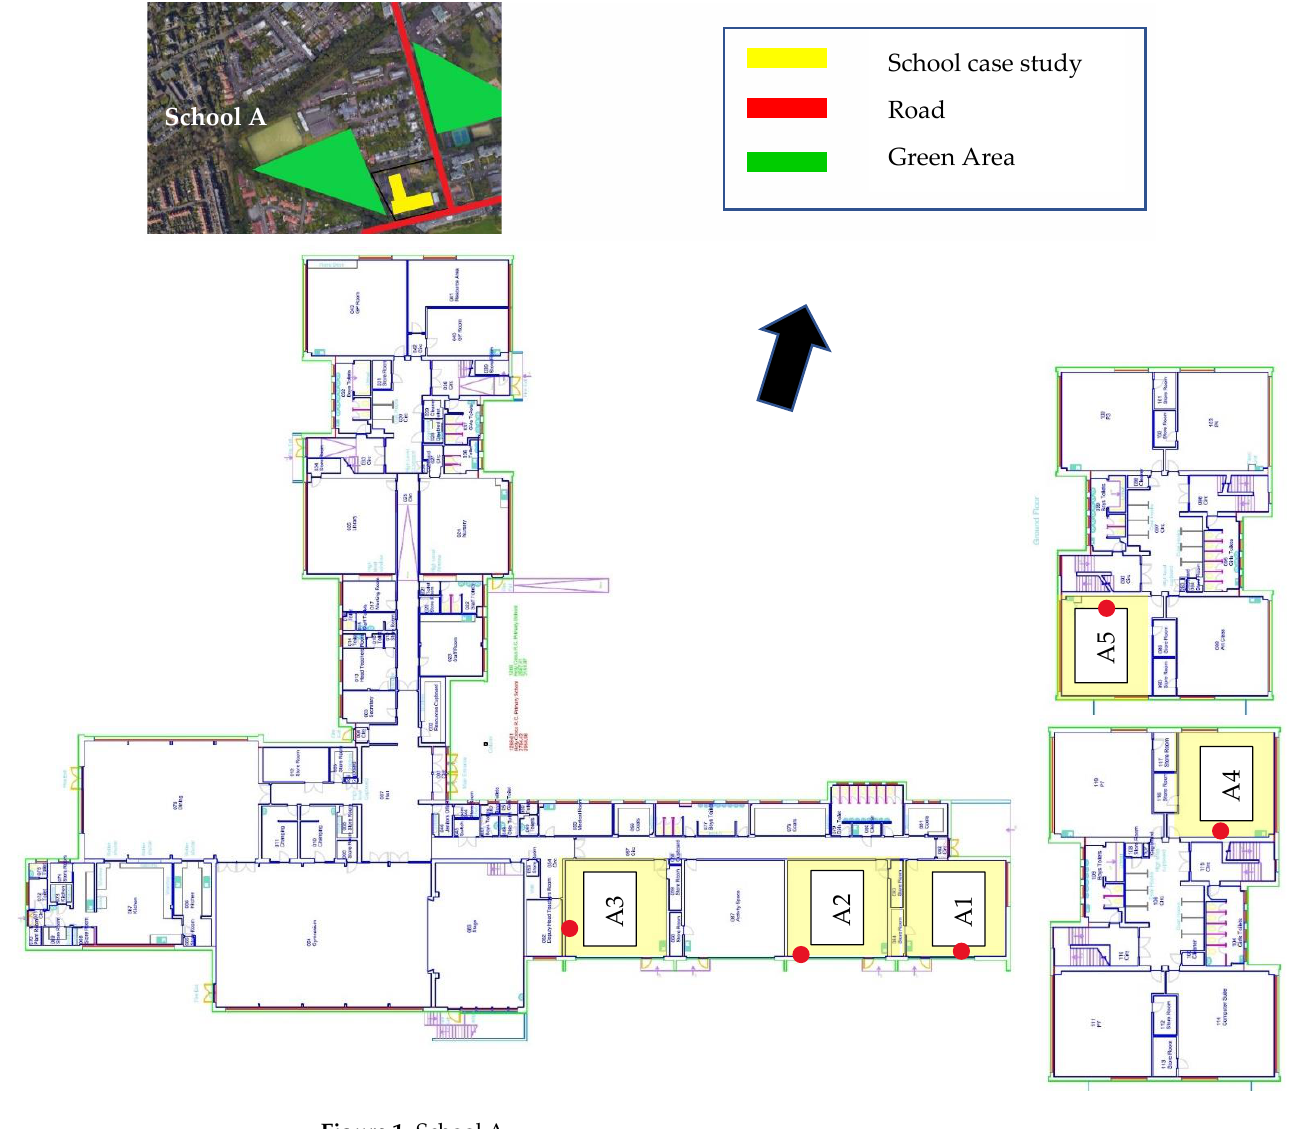
Figure 2. Picture of school A.